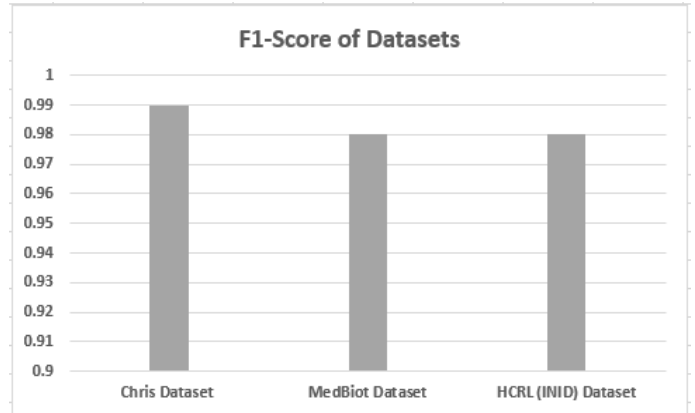
Figure 9. F1-score of different datasets.